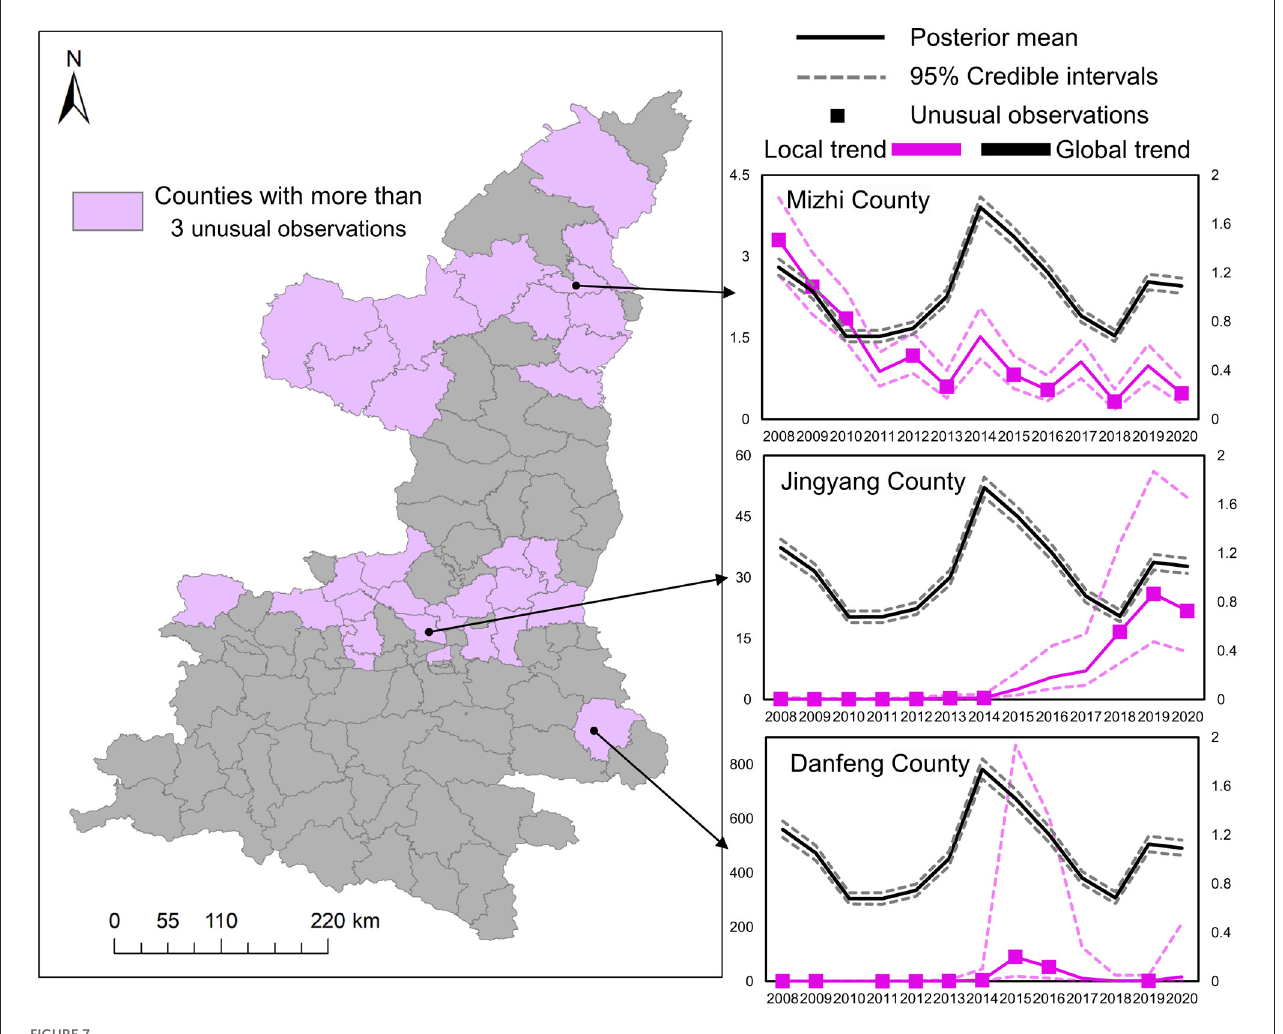
FIGURE7 The difference between local trends and the global common trend.